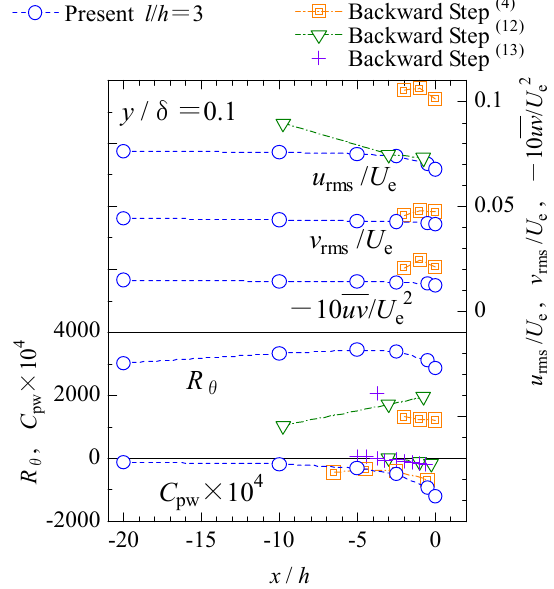
Fig. 7 Comparison with related flow